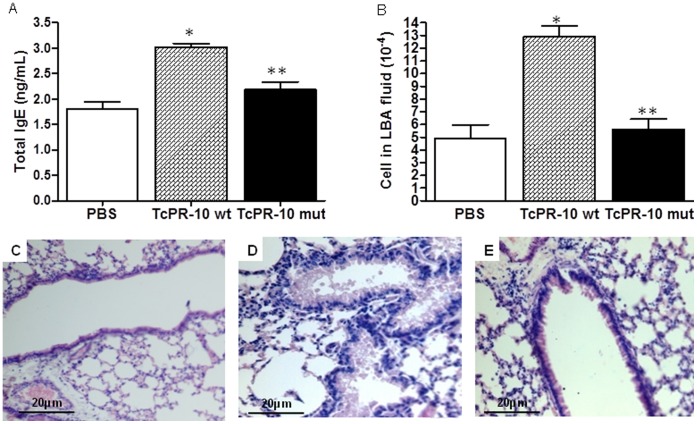
Quantification of polyclonal IgE, BAL total cell count and histological illustration of the lung of BALB/c mice.
A. Quantification of polyclonal IgE antibody levels in serum of BALB/c mice. B. Cell counting in BAL fluid. The set average values per se quantification of antibodies and showed normal (p<0,05; Shapiro Wilk Test) using the comparison test of means the parametric Tukey Test (α = 0,05). *Significantly high values compared to control. **Significantly reduced values compared to TcPR-10 wt. Horizontal bars represent the mean value of each group. C. Lung were removed twenty-four hours after the last challenge. Lung tissue was fixed, embedded, cut into slices and stained with hematoxylin e eosin (H&E) solution. C: Sections from control; D: wild TcPR-10; E: mutant TcPR-10.